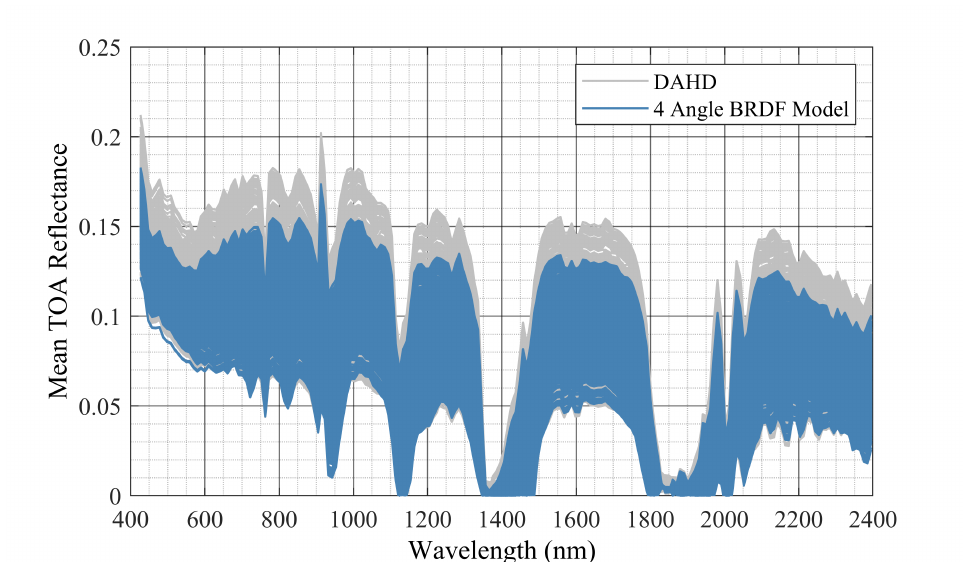
Figure 16. Dark hyperspectral dataset (grey) vs. 4-angle hyperspectral BRDF-model-predicted TOA reflectance profile (blue).